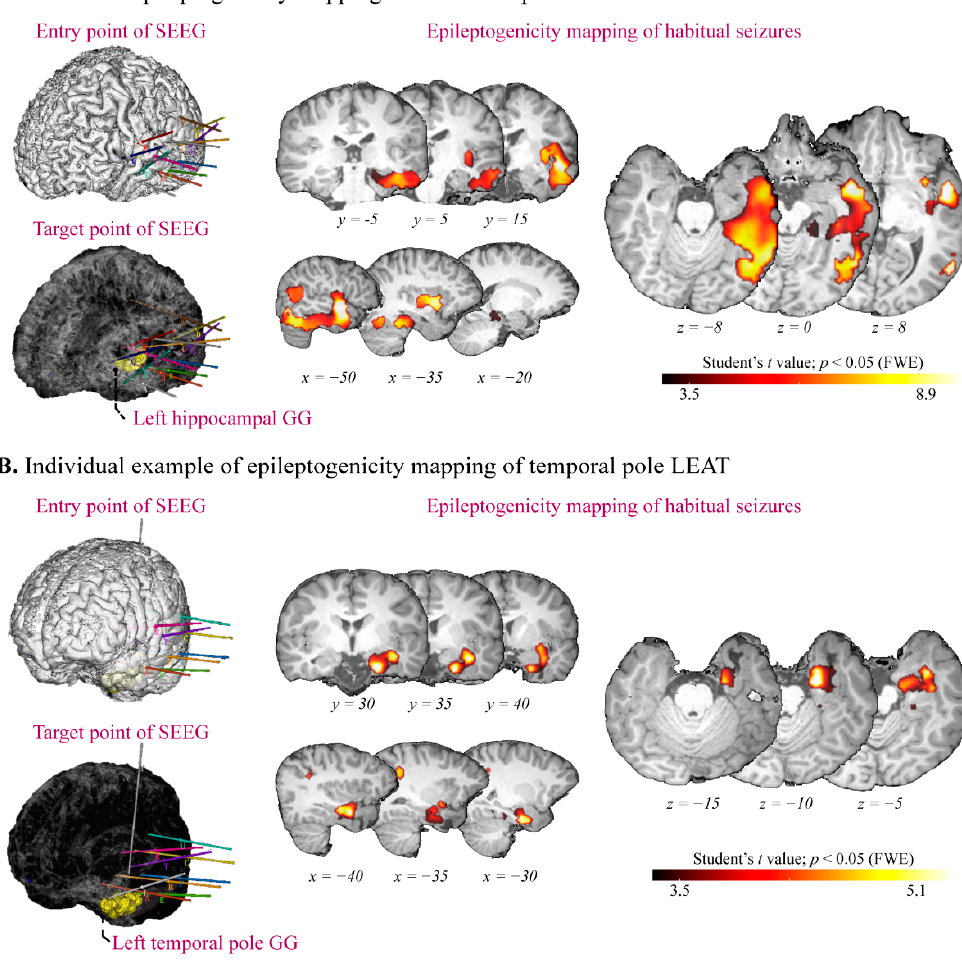
Figure 4. Epileptogenicity mapping of temporal lobe long-term epilepsy-associated tumors (LEAT). Representation of The SEEG implantation strategy, lesion location (left panel), and the epileptogenicity mapping (right panel) of ( A ) patient 64, with hippocampal ganglioglioma (GG) and ( B ) Patient 70, with temporal pole GG. FWE: family-wise error.